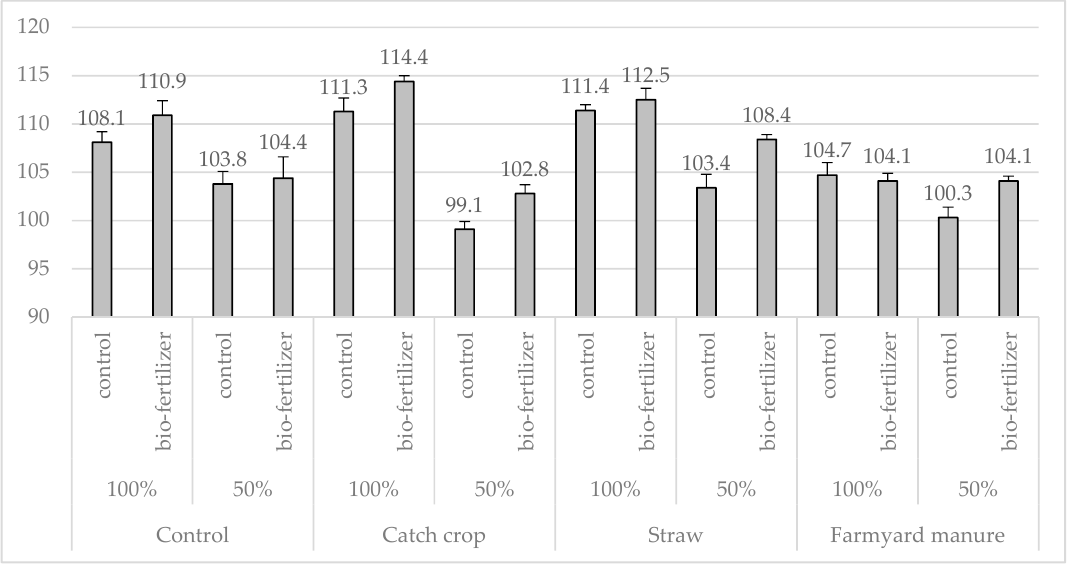
Figure 1. Content of crude protein in potato tubers as affected by organic, mineral, and bio fertilization, mean for three years of study (g· kg − 1 of dry weight). 100%, 50%-rate of mineral fertilization with NPKLSD (Tukey-test at p P ≤ 0.05) Organic sources = 3.595; mineral fertilizers = 1.282; Bio-fertilizers = 0.553.